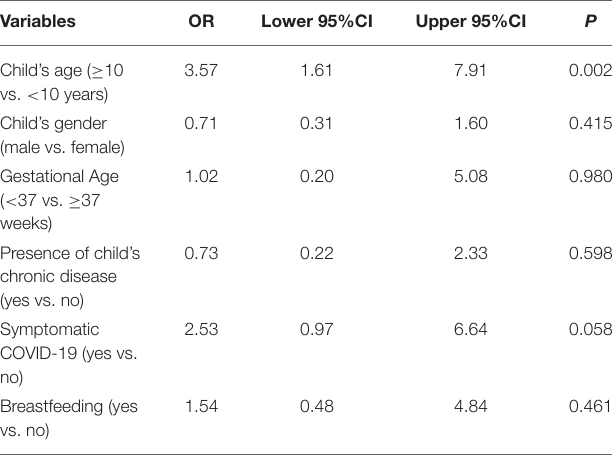
TABLE 2 | Multivariate binary logistic regression predicting the likelihood of having long COVID (dependent